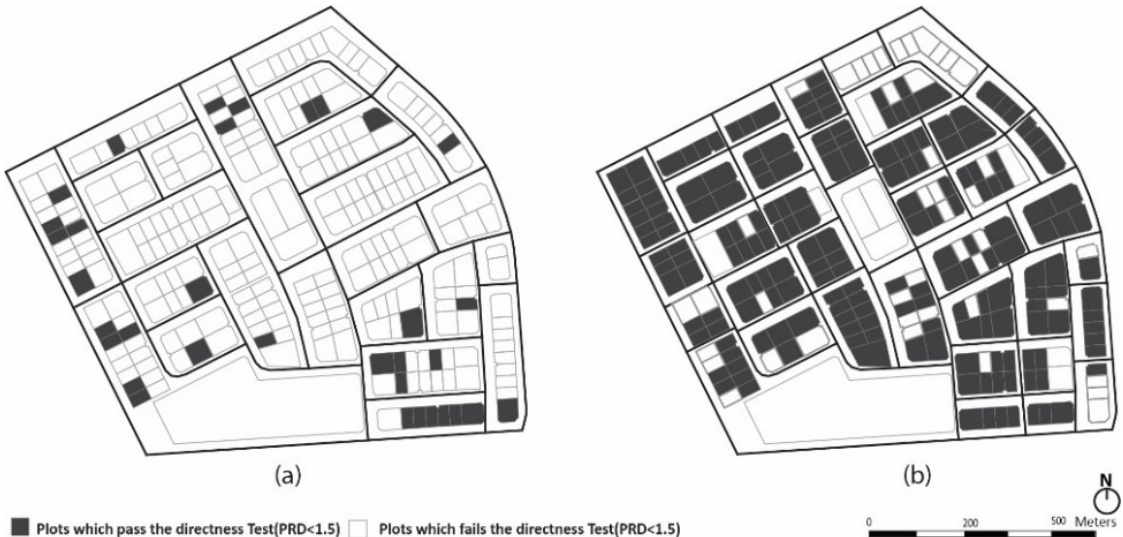
Figure 5. ( a ) Route directness results in terms of passing plots (shown in a darker color) using Network 1; ( b ) route directness results in terms of passing plots (shown in darker color) using Network 2, the network that included potential sikkak.